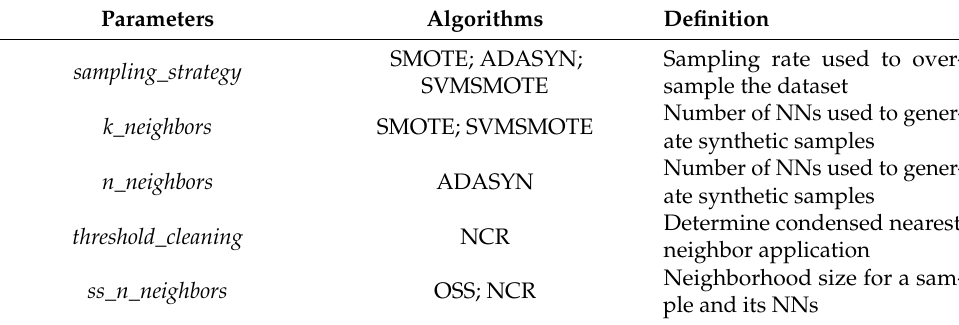
Table 1. Oversampling and undersampling